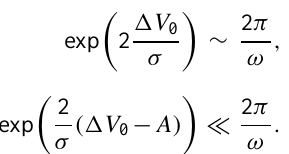
Fig. 4. A cartoon to explain the mechanism of stochastic resonance. The period of the oscillation is T . At time t = 0 the climate states has low probability to jump from + 1 to − 1. At time t = T/ 2 the situation is reversed: the probability no to jump is extremely